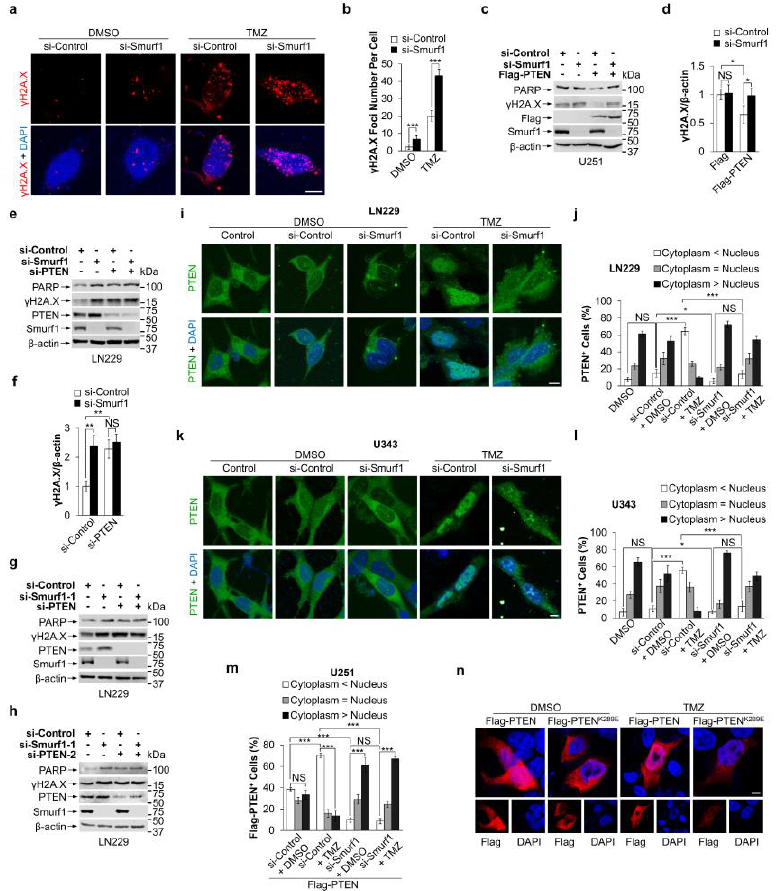
Figure A2. Smurf1 facilitates PTEN nuclear translocation to repair DNA damage under TMZ treat- ment. ( a , b ) LN229 were transfected with si − Control and si − Smurf1, then treated with DMSO or TMZ (250 μM, 48 h). The cells were immunofluorescence stained with anti −γH2A.X antibody. DAPI stained the nucleus. Bar: 5 µm. The graph shows quantitation of foci number per cell ( n = 10 cells examined over three independent experiments) ( b ). ( c , d ) U251 with Flag or Flag − PTEN overexpres- sion were transfected with si − Control or si − Smurf1. Whole − cell lysates were examined by Western blotting with anti − PARP and anti −γH2A.X antibodies ( c ). The overexpression or knockdown effi- ciency was examined with anti − Smurf1, anti − PTEN, or anti −Flag antibodies. β− actin was used as a loading control. The graph shows the relative γH2A.X intensity ( d ). Values were normalized against the amount of LN229 transfected with control siRNA oligos and Flag. ( e – h ) LN229 cells were trans- fected with si − Control, si − Smurf1, si − Smurf1 − 1, si − PTEN, or si − PTEN − 2. Whole − cell lysates were examined by Western blotting with anti − PARP and anti −γH2A.X antibodies ( e , g , h ). The overex- pression or knockdown efficiency was examined with anti − Smurf1, anti − PTEN, or anti − Flag anti- bodies. β− actin is used as a loading control. The graph shows the relative γH2A.X intensity in Figure A2e ( f ). Values were normalized against the amount of LN229 transfected with control siRNA oligos and Flag. ( i – m ) LN229 cells ( i , j ), U343 cells ( k , l ), and U251 cells with Flag − PTEN ( m ) were trans- fected with si − Control or si −Smurf1 and then treated with DMSO or TMZ (250 μM, 48 h). The cells were immunofluorescence stained with anti − PTEN antibody. DAPI stained the nucleus. Bar: 5 µm. The graph shows quantitation of PTEN subcellular localization. ( n ) U251 were transfected with Flag − PTEN or Flag − PTEN K289E and then treated with DMSO or TMZ (250 μM, 48 h). The cells were immunofluorescence stained with anti − Flag antibody. DAPI stained the nucleus. Bar: 5 µm; Western blot analysis was performed in n = 3 biological replicates. In ( d , f , j , l , m ), data are presented as mean ± SD of three separate experiments, NS p > 0.05, * p < 0.05, ** p < 0.01, *** p < 0.001 as determined by unpaired two −tailed Student’s t − test.